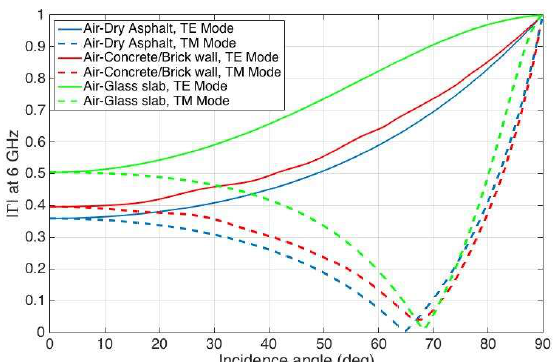
Figure 6. Horizontal incidence angle, 𝜙 (cid:3020) , elevation angle, 𝜓 (cid:3046) , and incidence angle, 𝜃 , of a single ray (left) and example of two sample rays (right) having the same elevation angle, 𝜓 (cid:3046) , and different azimuth angles, 𝜙 (cid:3020)(cid:2869) and 𝜙 (cid:3020)(cid:2870) .